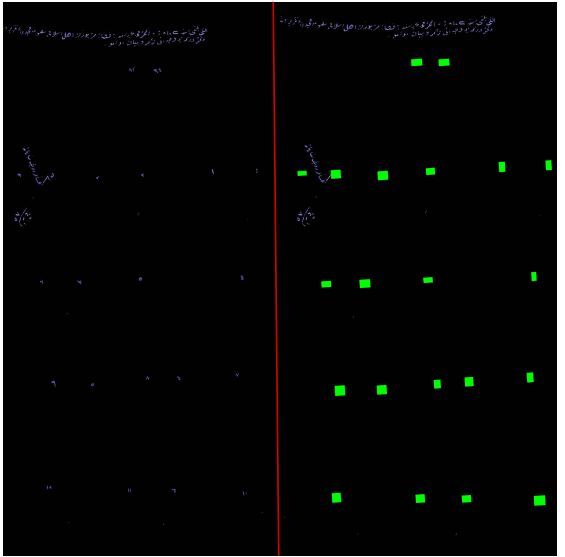
Figure 4. In the left, the red filtered register image is shown. In the right, the numerals marked and annotated for training the CNN model.